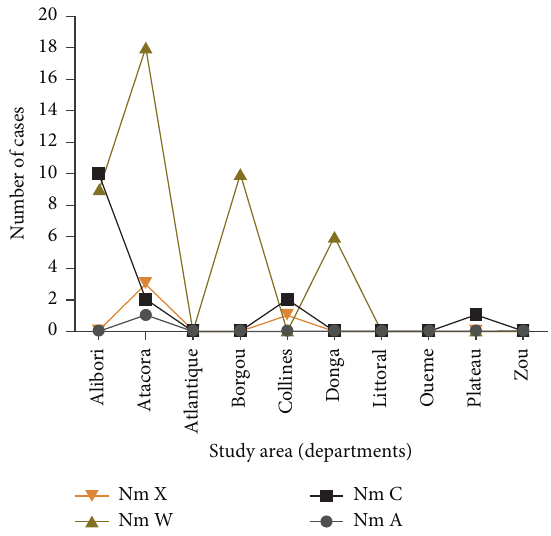
Figure 2: Distribution of the frequency of N. meningitidis serogroups according to the departments in the Republic of Benin from 2016 to 2018.